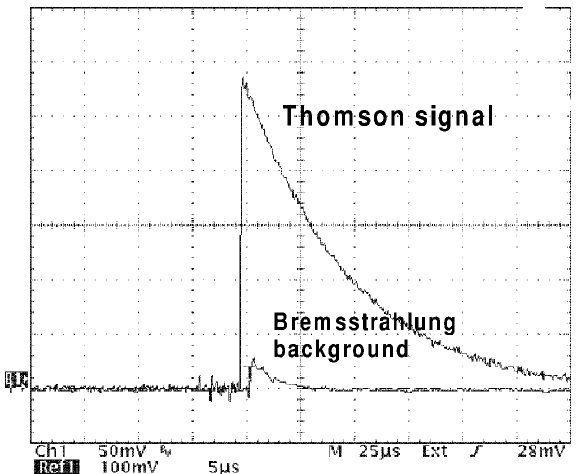
FIG. 10. Typical scope traces of the x-ray signal (at 100 mV (cid:1) div) and noise (at 50 mV (cid:1)